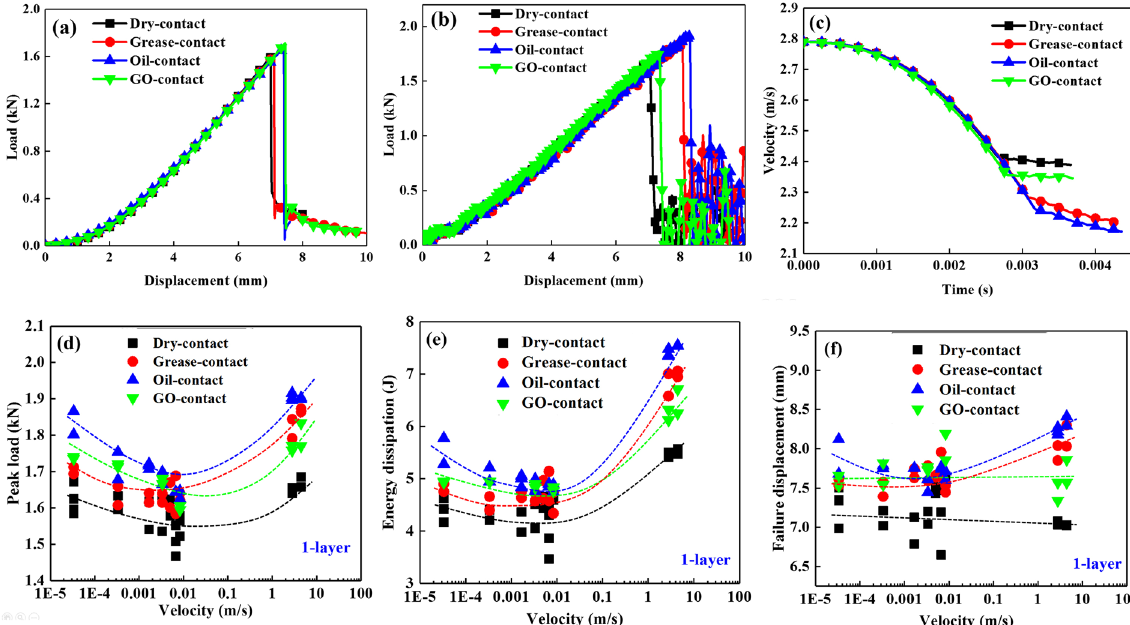
Figure 4. Mechanical responses of a single-layer aluminium sheet: ( a ) load-displacement curves under 3.33 × 10 − 4 m/s quasi-static loading, ( b ) load-displacement curves under 2.79 m/s impact loading, ( c ) velocity- time curves under 2.79 m/s impact loading, and mechanical properties as a function of loading velocity of ( d ) peak-load, ( e ) energy dissipation and ( f ) failure